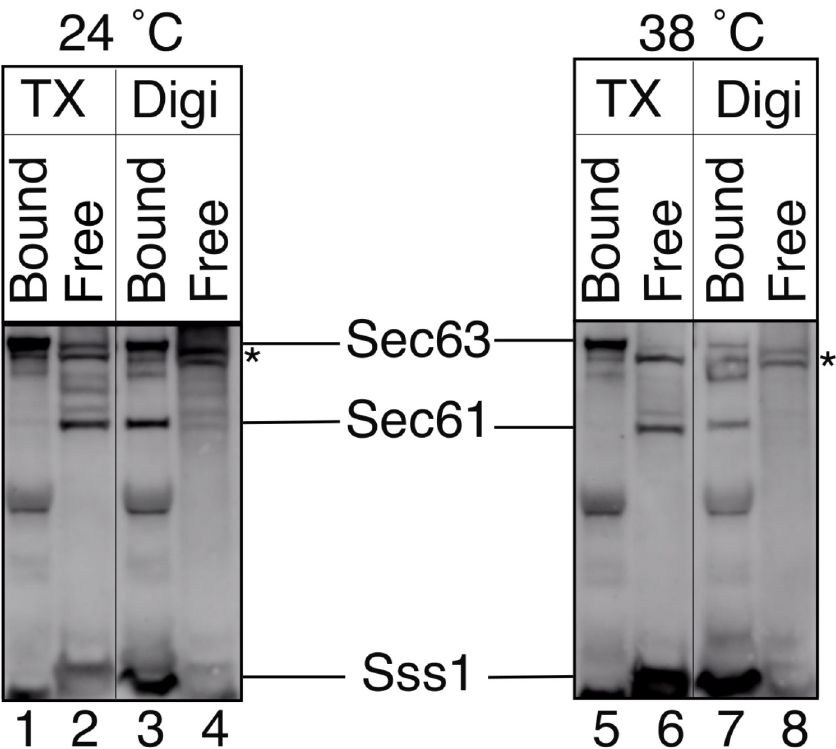
Fig 7. The Sec complex remains stable in the absence of Sbh1. Microsomes derived from Δ sbh1 Δ sbh2 yeast grown at permissive (24 ˚C) and restrictive (38 ˚C) temperature were solubilized in 3% (w/v) digitonin (Digi) or 1% (w/v) Triton X-100 (TX). Insoluble components were removed by centrifugation and cleared lysates were incubated with Concanavalin A-Sepharose. Unbound complexes (Free) and Concanavalin A-bound proteins (Bound) were analyzed by SDS-PAGE and immunoblotting with specific antibodies against Sec63, Sec61, and Sss1. The asterisk marks a doublet cross-reacting with the Sec63